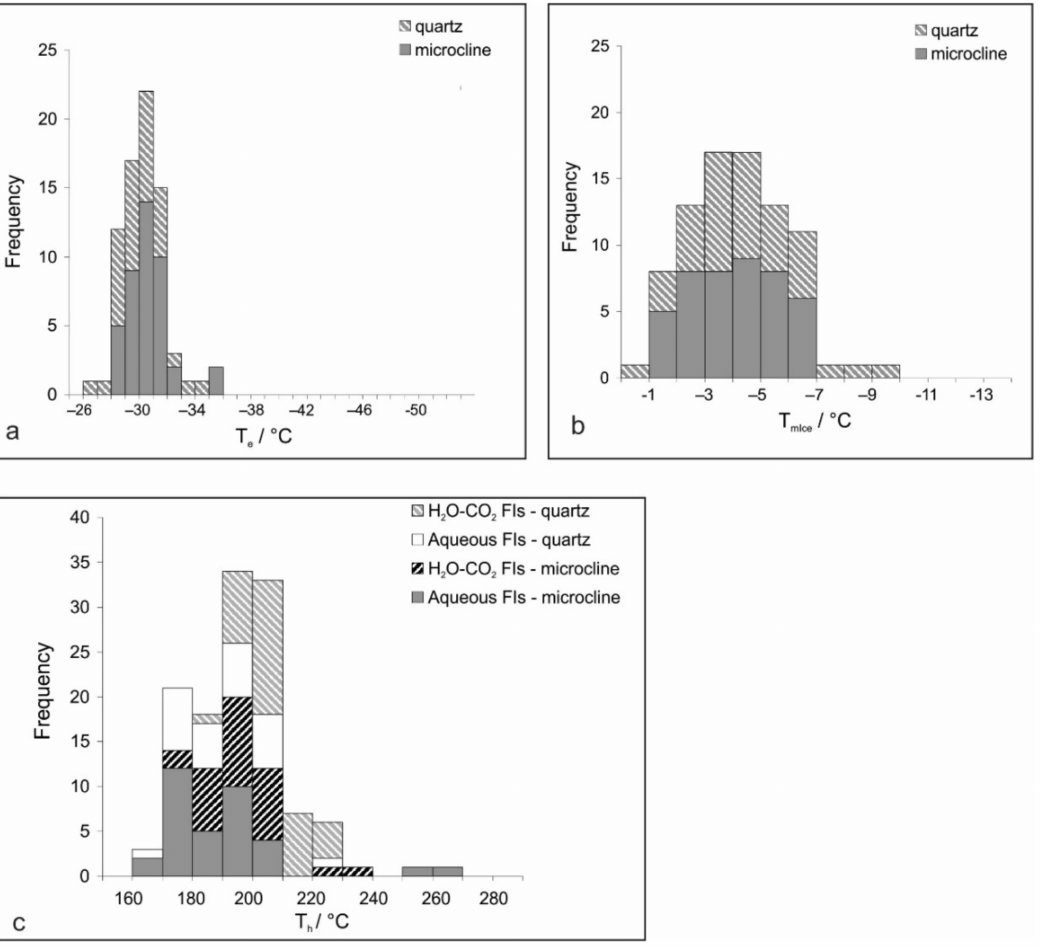
Figure 5. Histograms showing frequency distributions of fluid inclusion data: ( a ) Eutectic temperature ( Te ); ( b ) Final melting temperature of ice ( T mIce ); ( c ) Homogenization temperature ( T h